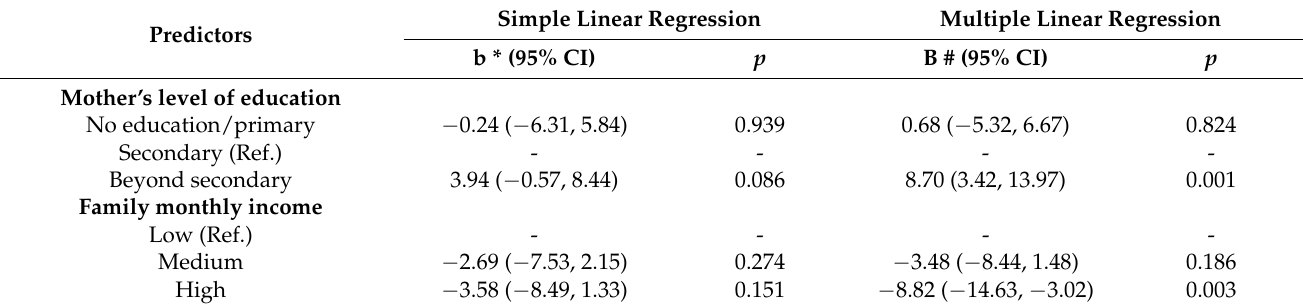
Table 4. Factors Associated with Total Family Impact ( n =